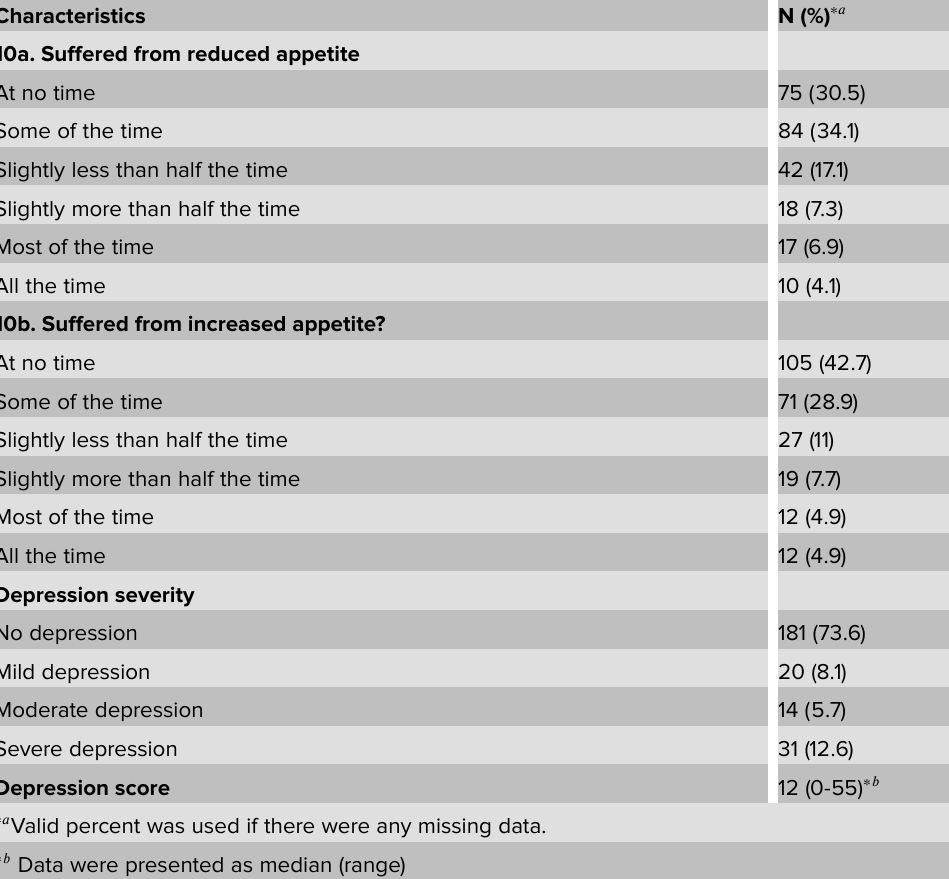
Table 3: MDI questions for depression.